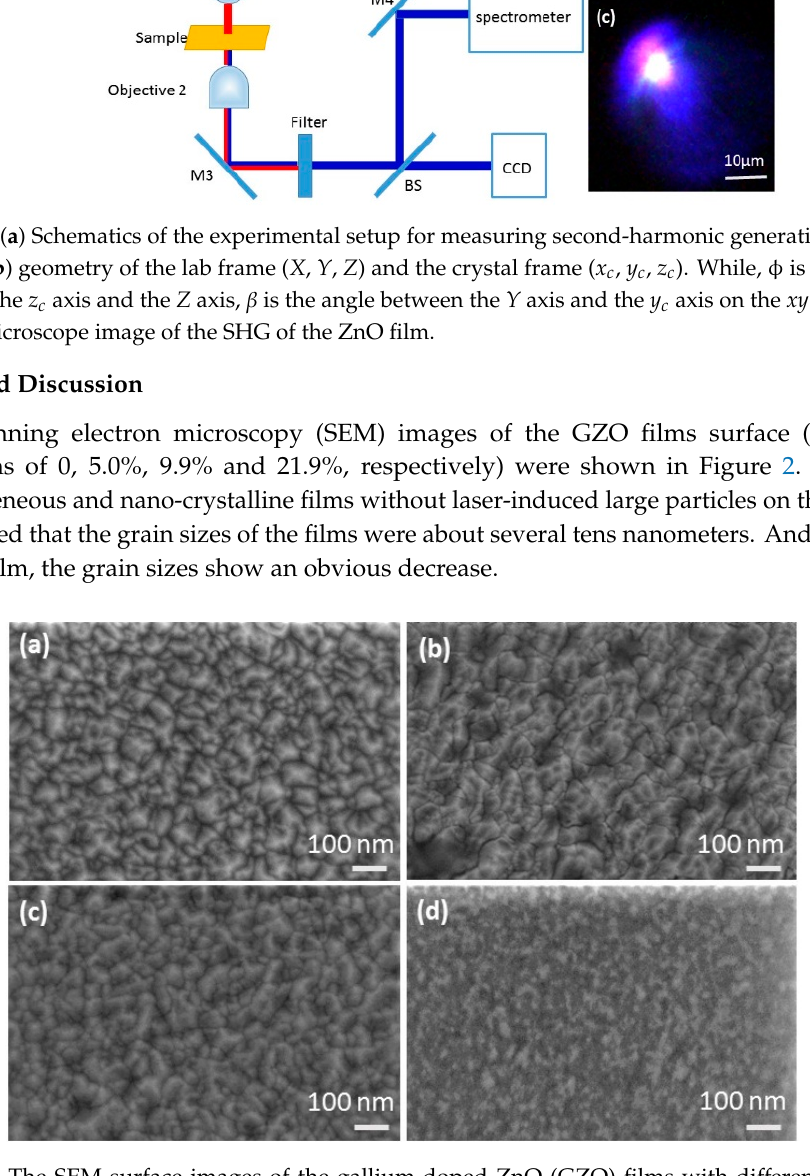
Figure 2. The SEM surface images of the gallium doped ZnO (GZO) films with different doping concentrations. ( a ) 0; ( b ) 5.0%; ( c ) 9.9%; ( d ) 21.9%.